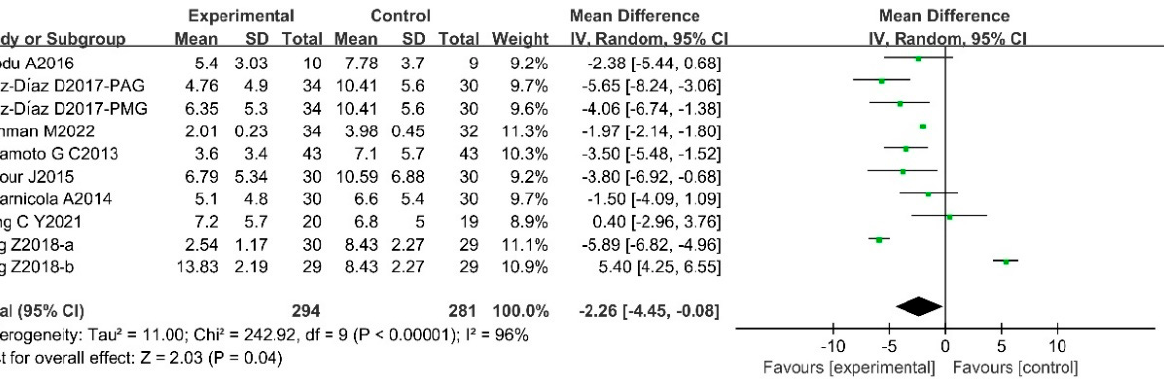
Figure 6. Meta-analysis of the effect of Pilates on RMDQ in CLBP patients [20,23,36,48,49,51,54].